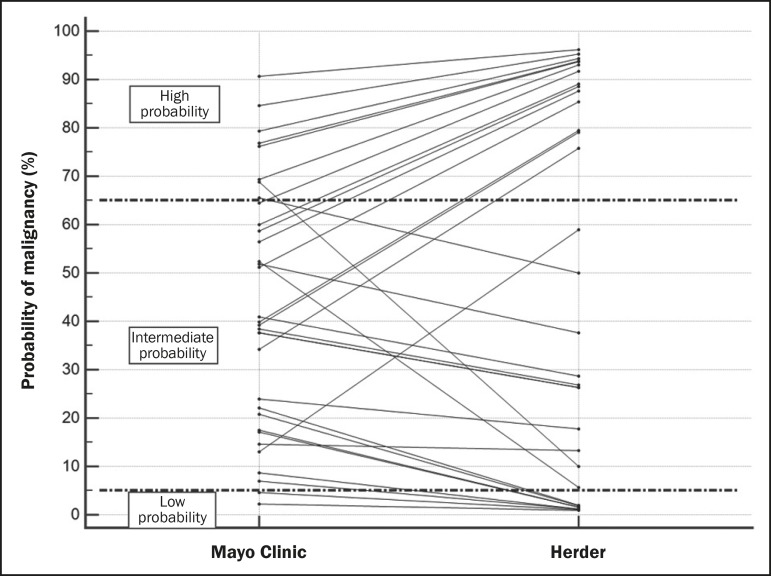
Variation in the probability of malignancy classification per patient according to each model.